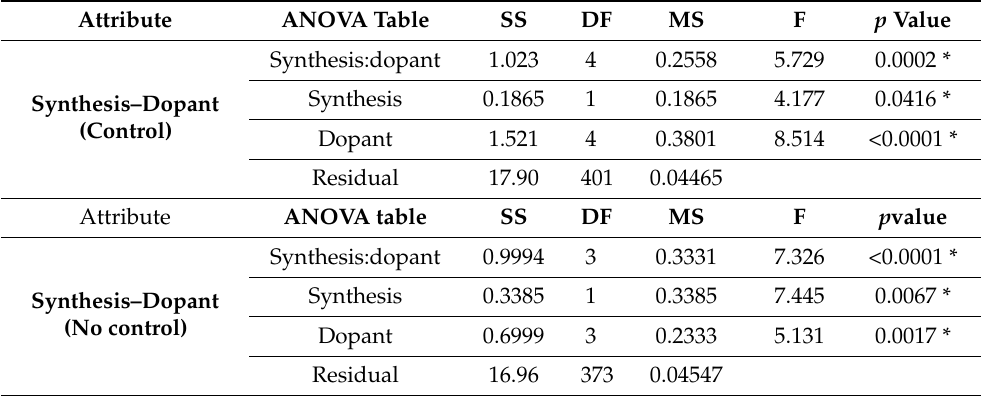
Table 9. Two-way ANOVA test for the chlorophyll